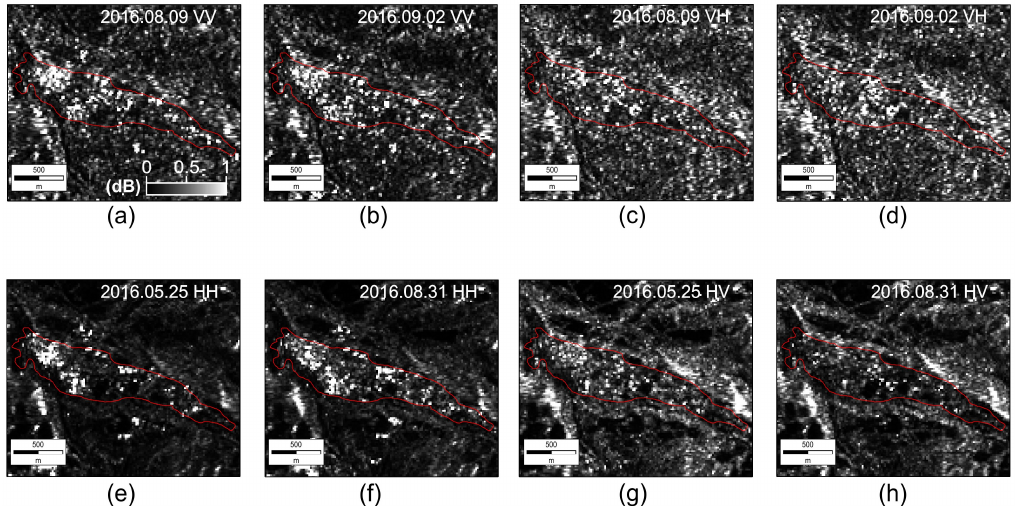
Figure 4. Pre- and post-event Sentinel-1 ( a – d ); and ALOS-2 ( e – h ) intensity images for the target area. The red boundary defines the town of Amatrice.